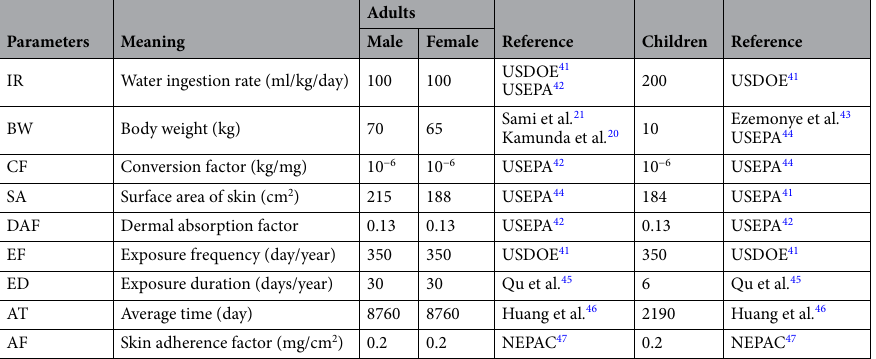
Table 1. Exposure parameters and represented values adopted for estimation of human health risk of metals in Egbokodo